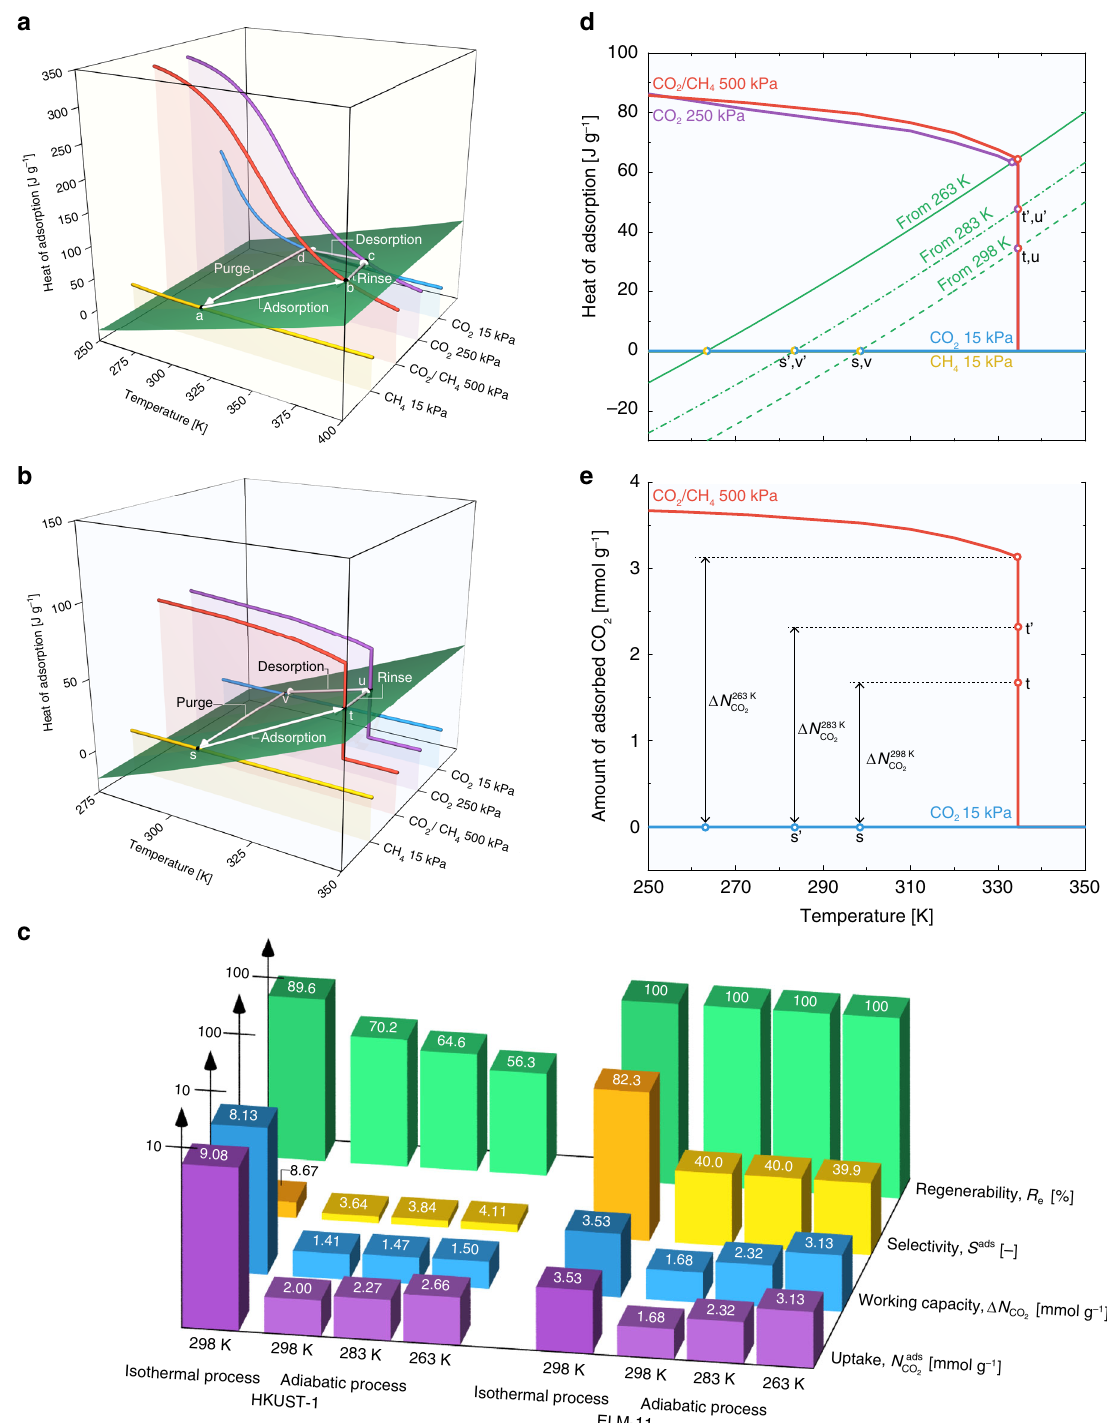
Fig. 5 Adsorption properties of HKUST-1 and ELM-11 under adiabatic conditions. Temperature dependence of heat of adsorption for a HKUST-1 and b ELM-11. Red line: adsorption of an equimolar CO 2 /CH 4 gas mixture at 500 kPa, purple line: pure CO 2 adsorption at 250 kPa, blue line: pure CO 2 adsorption at 15 kPa, and yellow line: pure CH 4 adsorption at 15 kPa. The green plane shows the heat required to change the temperature of the host framework. White arrows represent the four adiabatic operating processes of rapid pressure vacuum swing adsorption (PVSA). The starting temperature was set as 298 K. c CO 2 separation characteristics of HKUST-1 and ELM-11 for PVSA assuming the adiabatic operations and the starting temperatures of 298, 283, and 263 K together with those assuming isothermal operations at 298 K. d Temperature dependence of net heat of adsorption for ELM-11 for adsorption of an equimolar CO 2 /CH 4 gas mixture at 500 kPa (red), pure CO 2 at 250 kPa (purple), pure CO 2 at 15 kPa (blue), and pure CH 4 at 15 kPa (yellow). Green lines are the heat balance curves when the adiabatic adsorption process starts from 298, 283, and 263 K. e Temperature dependence of the amount of CO 2 adsorbed on ELM-11 for an equimolar CO 2 /CH 4 mixture at 500 kPa (red) and that for pure CO 2 at 15 kPa